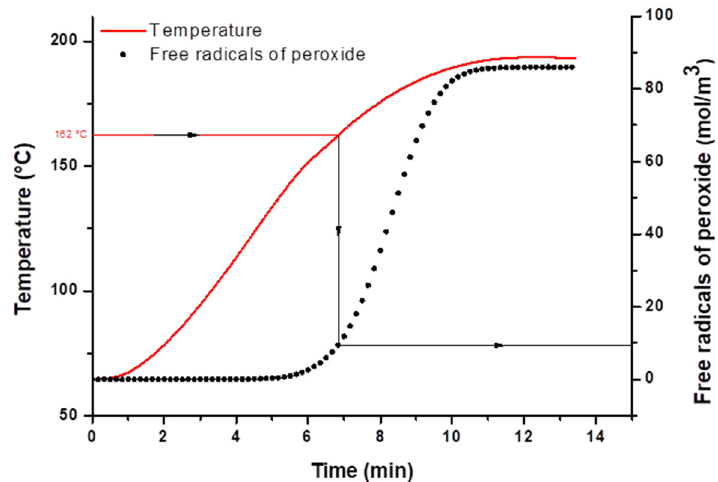
Figure 4. Prediction of free radical concentration generated during mixing in the EPDM phase from thermal dicumyl peroxide (DCP) composition. The temperature curve is from melt temperature recorded during the mixing experiment (Formulation depicted in Figure 3).